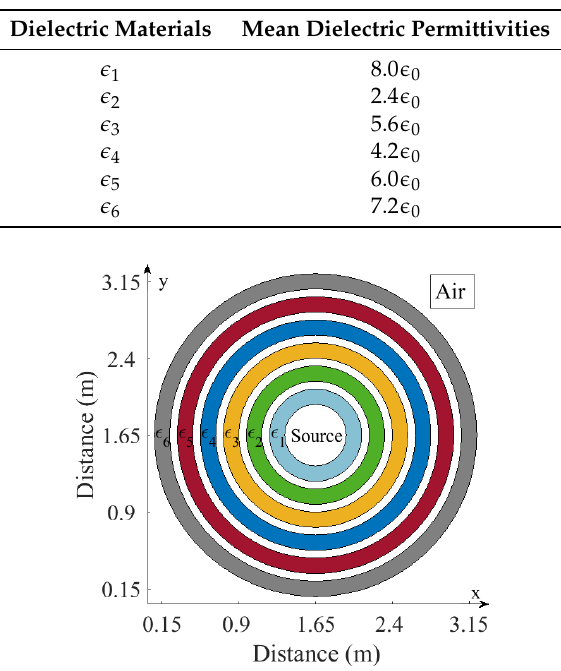
Figure 5. Geometric features of the 2D problem.